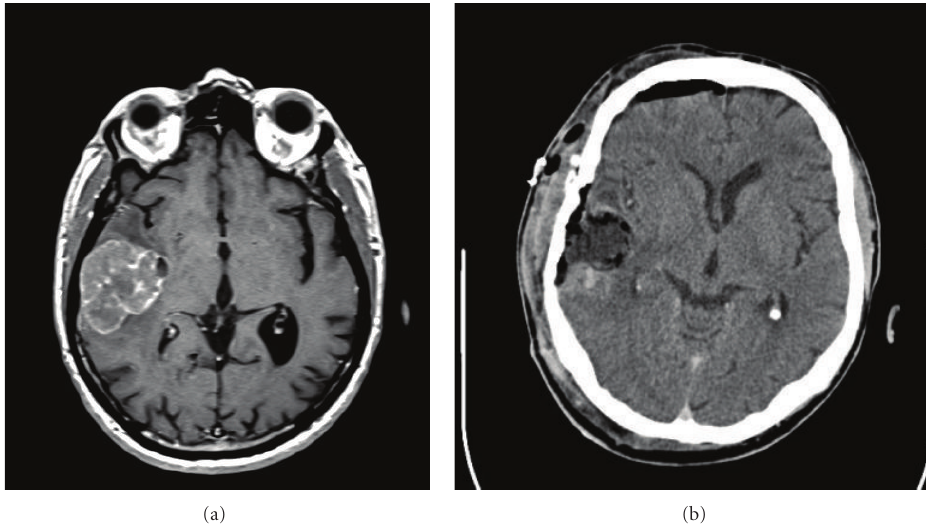
Figure 1: (a) Preoperative T1 axial contrast MR images showing a right temporal lesion with surrounded edema. (b) Postoperative head CT scan showing gross-total resection of the lesion.